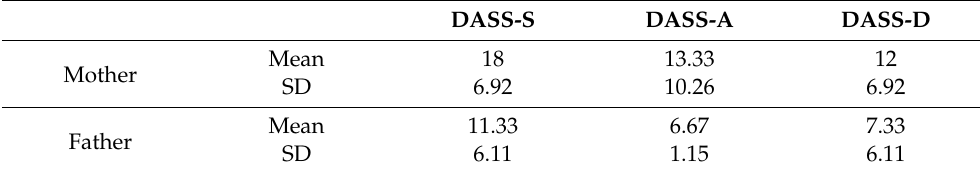
Table 1. Mean differences in DASS Test scores.